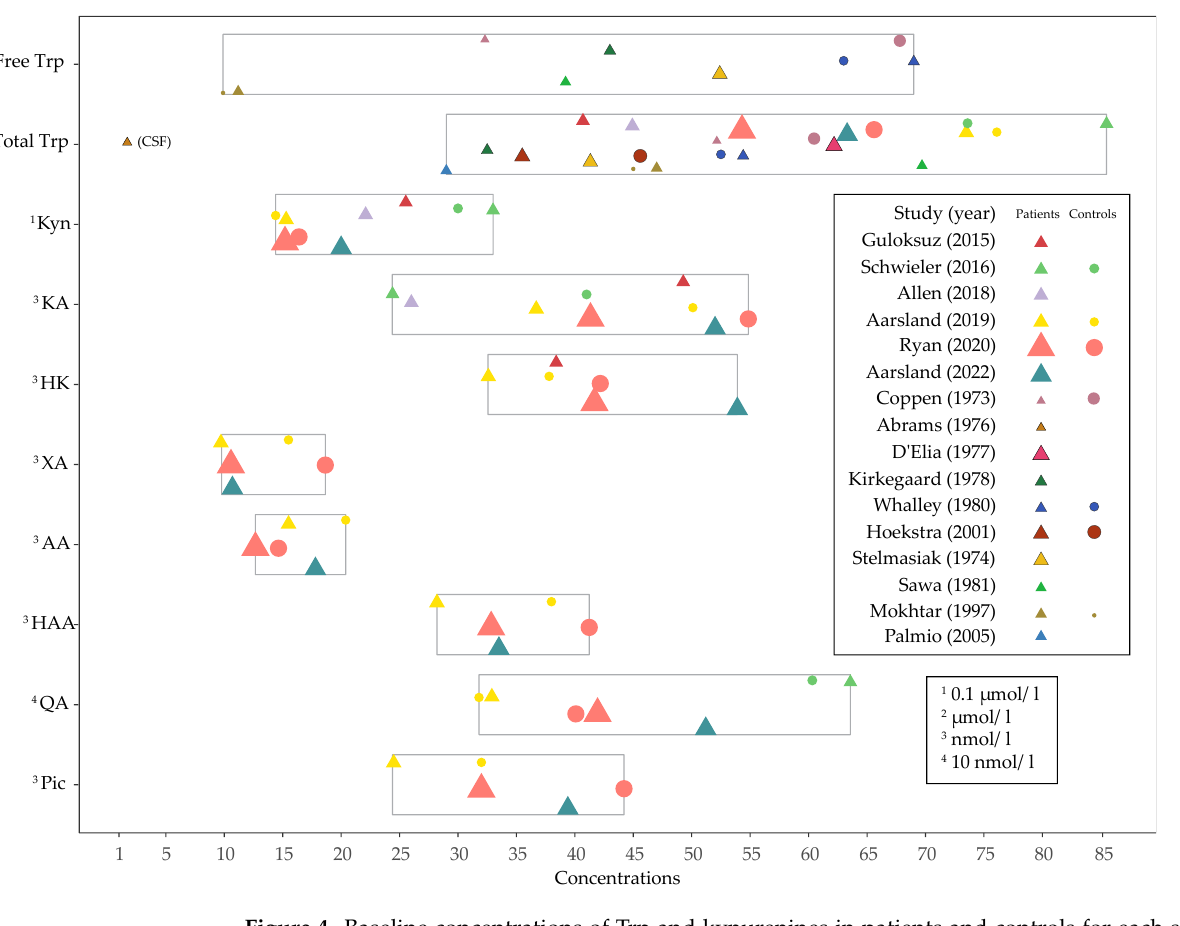
Mokhtar (1997) [69], Palmio (2005) [71]. Percentage change after ECT of Trp, kynurenines and kynurenine pathway ratios are shown in Figure 4. Free Trp, total Trp, Kyn, KA and KTR were available in an adequate number of studies to utilize vote counting based on effect direction (exact binomial test, binom.test).